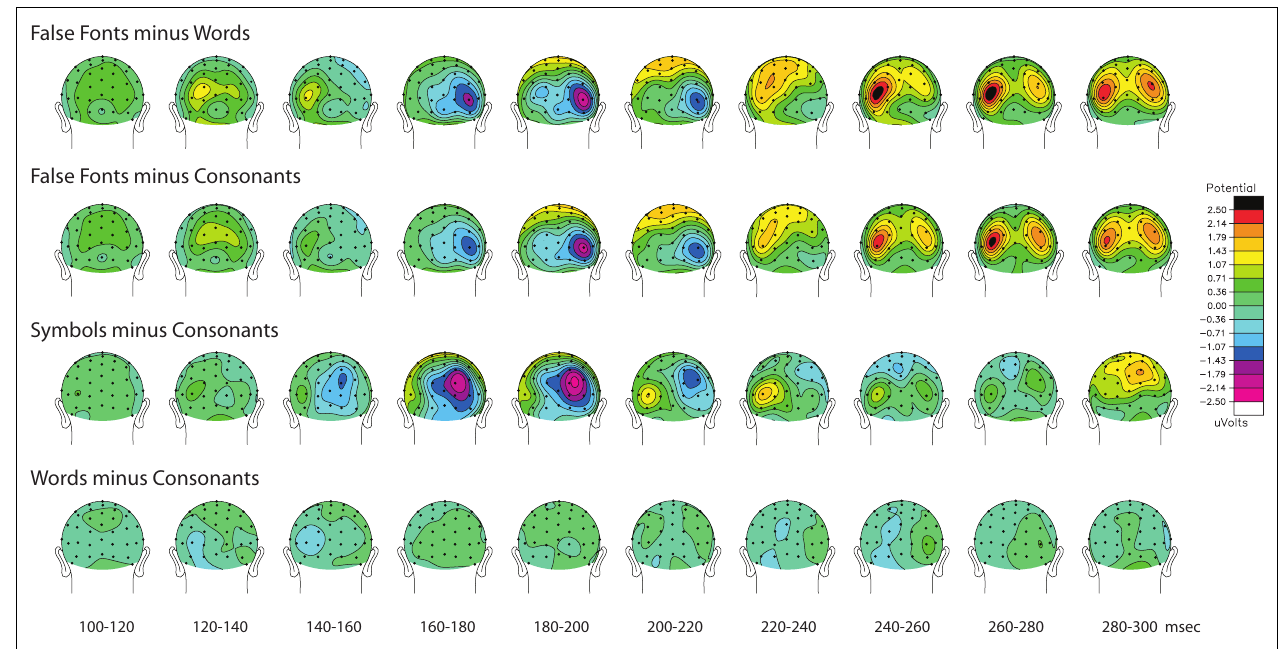
FIGURE 4 | Sequential topographic maps (posterior view) across time of the grand average voltage distributions for the different contrasts, as